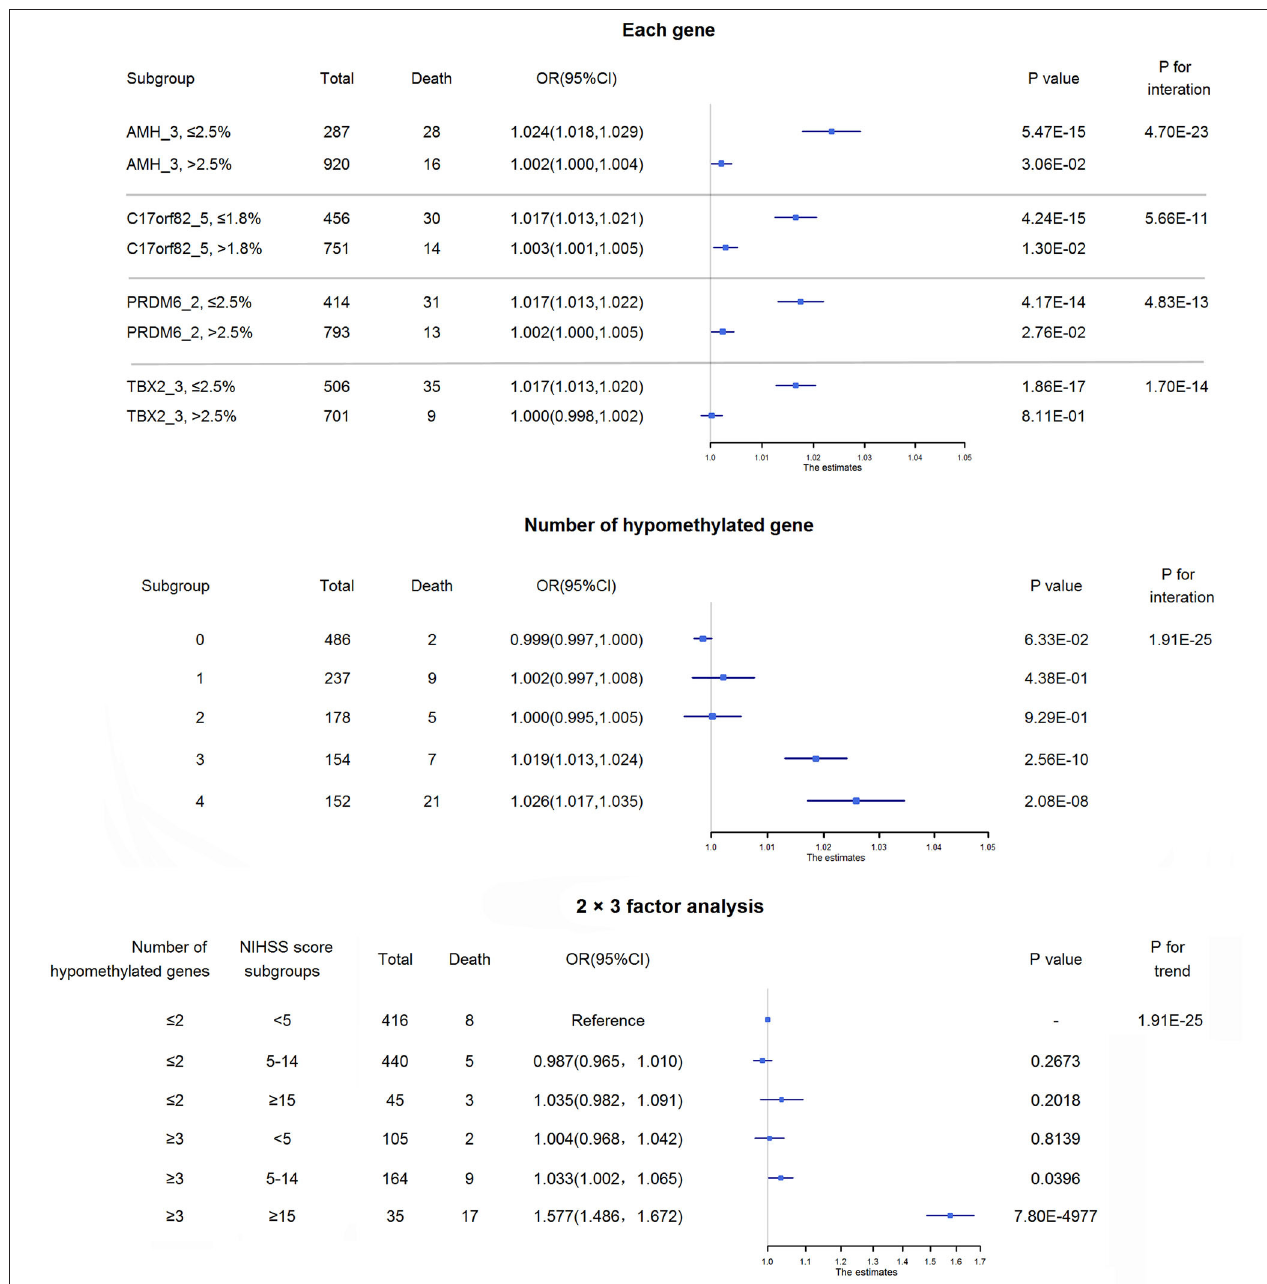
FIGURE 6 | Interactions between methylations and disease severity on mortality. The upper panel shows the interaction effects between hypomethylation of each of the four targets and NIHSS score on 3-month mortality. The increased risk of death per 1-point increase in NIHSS score was higher in patients with hypomethylation of each of these 4 targets than in those without hypomethylation of the corresponding target. The middle panel shows the adjusted ORs and corresponding 95% CIs for the associations between NIHSS score and 3-month mortality among subgroups of acute ischemic stroke patients according to the number of hypomethylated targets. The increased risks of death per 1-point increase in NIHSS score were higher in patients with 3 or 4 hypomethylated targets than in those without hypomethylated targets. The lower panel shows the combined effect of the number of hypomethylated targets and disease severity on 3-month mortality. Patients were separated by the number of hypomethylated targets (separated by ≤ 2 hypomethylated targets and ≥ 3 hypomethylated targets) and disease severity (minor stroke: NIHSS score < 5, moderate stroke: NIHSS score 5–14, severe stroke: NIHSS score ≥ 15). Approximately 25.4% of ischemic stroke patients may have 3 or 4 hypomethylated genes, and nearly 10% of them would die within 3 months of onset, while the 3-month mortality for the overall patients was ∼ 3%. Notably, for severe ischemic stroke patients with 3 or 4 hypomethylated genes, half of them died within 3 months of onset.